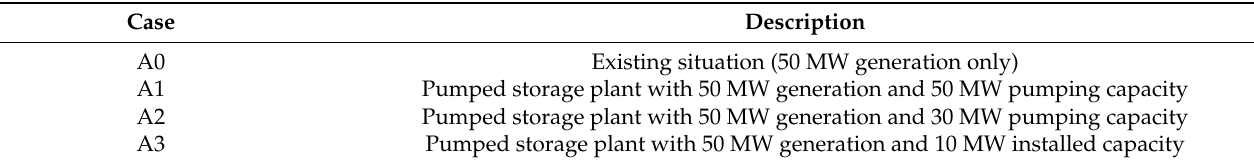
Table 2. Alternatives for production simulation of Roskrepp hydropower plant.